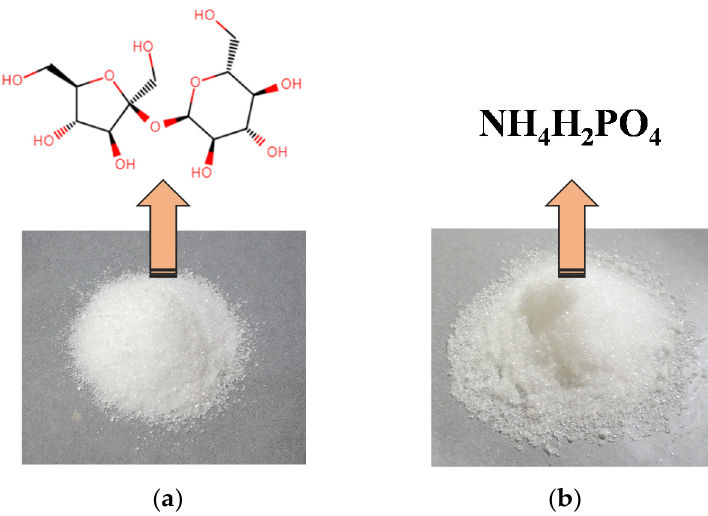
Figure 1. Appearance and chemical formula of ( a ) sucrose and ( b ) ammonium dihydrogen phosphate.